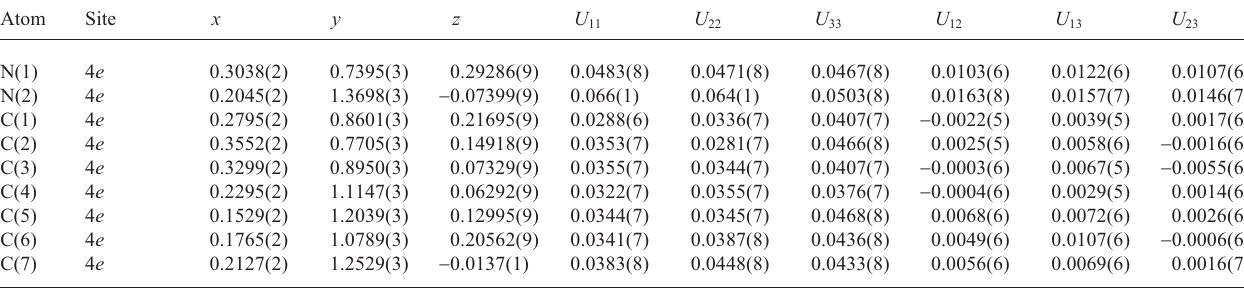
Table 3. Atomic coordinates and displacement parameters (in Å 2 )